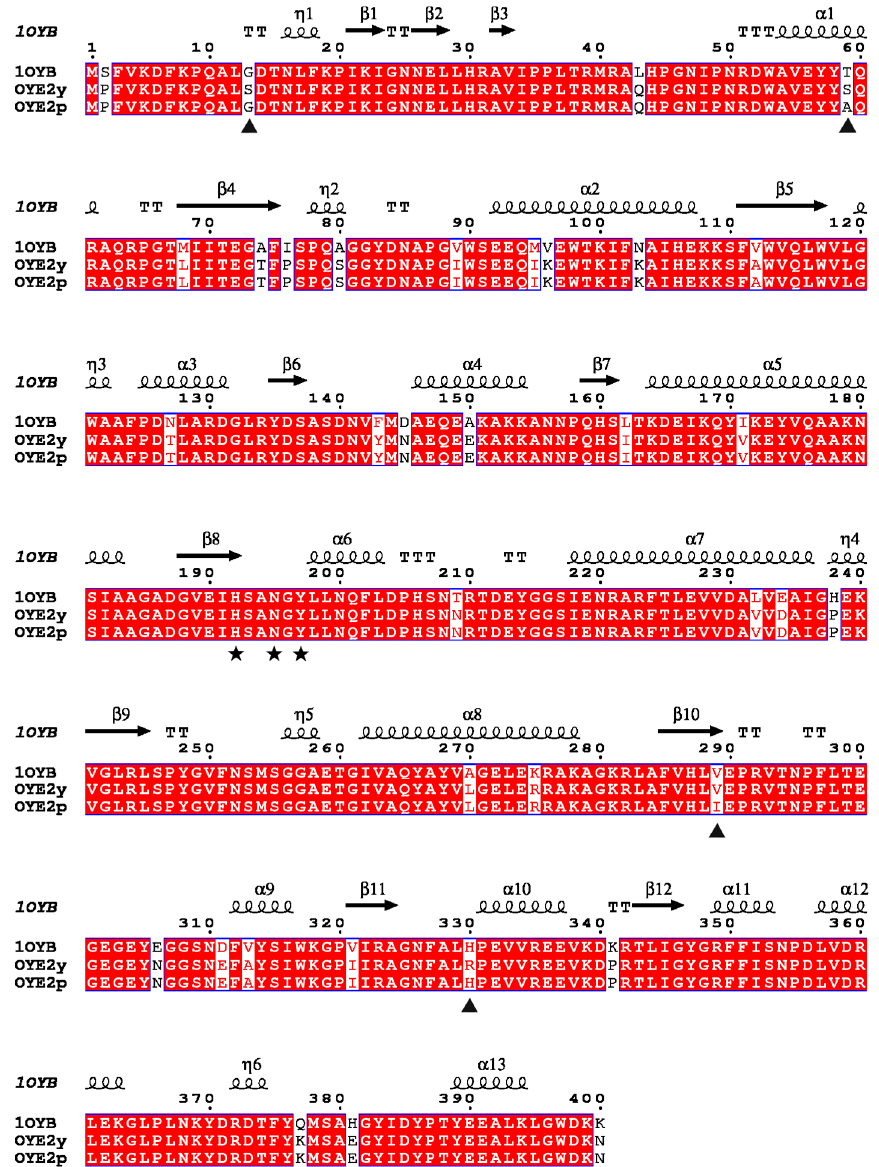
Figure 2. Structure-related sequence alignment between OYE2y and its homologous OYEs. 1OYB: PDB code of OYE1 from S. pastorianus ; OYE2p: NAD(P)H-dependent enoate reductase from S. cerevisiae YJM1341. The secondary structural elements of 1OYB ( α -helices, β -strands, T-turns, and η -helices) were indicated above the aligned sequences. The numbering shown was from 1OYB. A red background highlights conserved residues. ▲ , the positions where the amino acid residues differed between OYE2y and OYE2p; ★ , key residues for catalytic activity. The figure was produced using ESPript 3.0 [32].